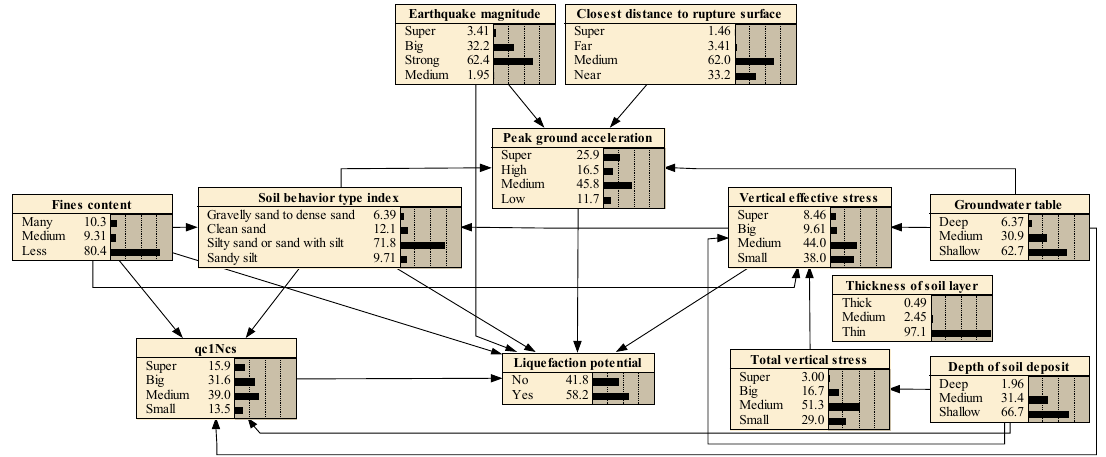
Figure 3. Graphical result of a BBN-based seismic soil liquefaction potential model using K2 and DK.